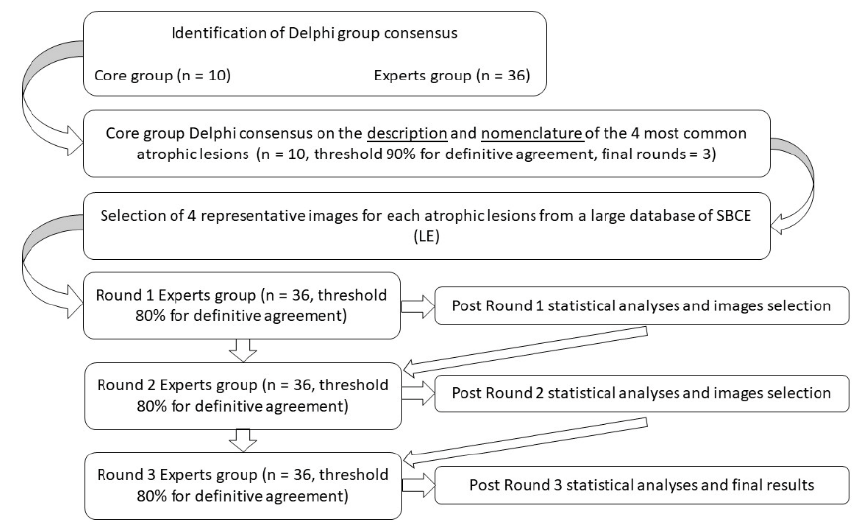
Figure 1. Flowchart of the Delphi process.